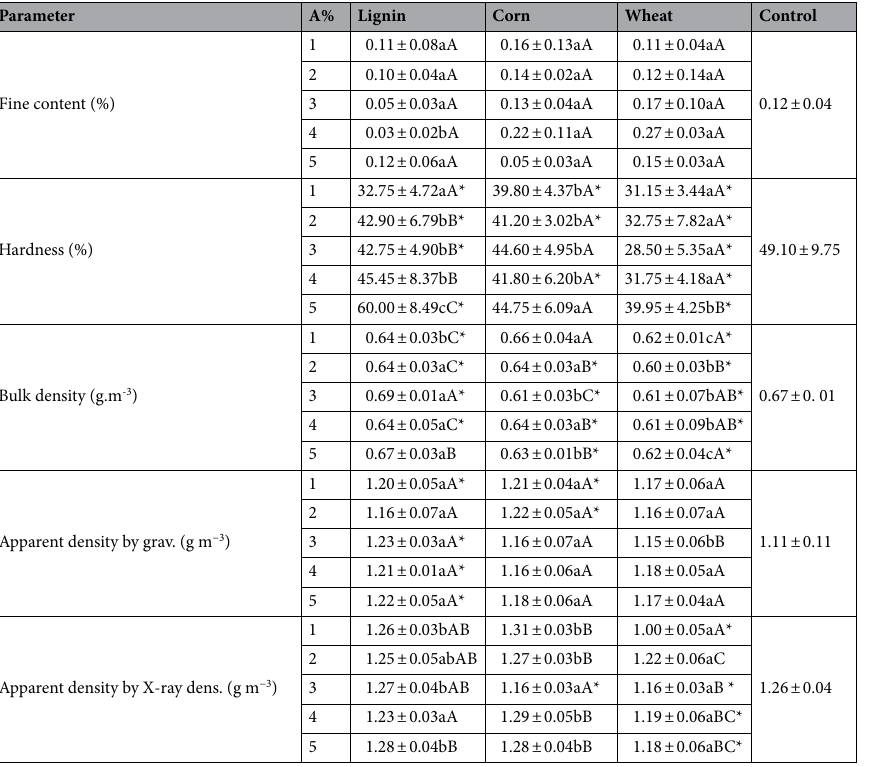
Table 1. Fine content (%), hardness (%), bulk density (g m −3 ), apparent density (g m −3 ) by gravimetric method and apparent density (g m −3 ) by X-ray densitometry of Pinus wood pellets produced with different percentages of the additives (A) corn and wheat and kraft lignin and in the control. Means followed by the same uppercase letter, per column, or lower case, per line, do not differ by Tukey test ( p > 0.05). *Differences between treatments and the control by the Dunnett test (α =